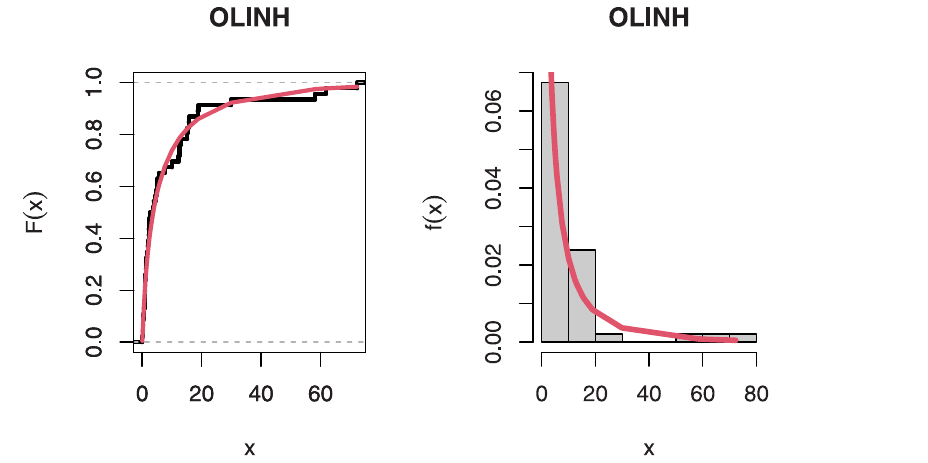
Fig 5. Estimated CDF and pdf of the OLINH distribution for COVID-19 vaccination data.